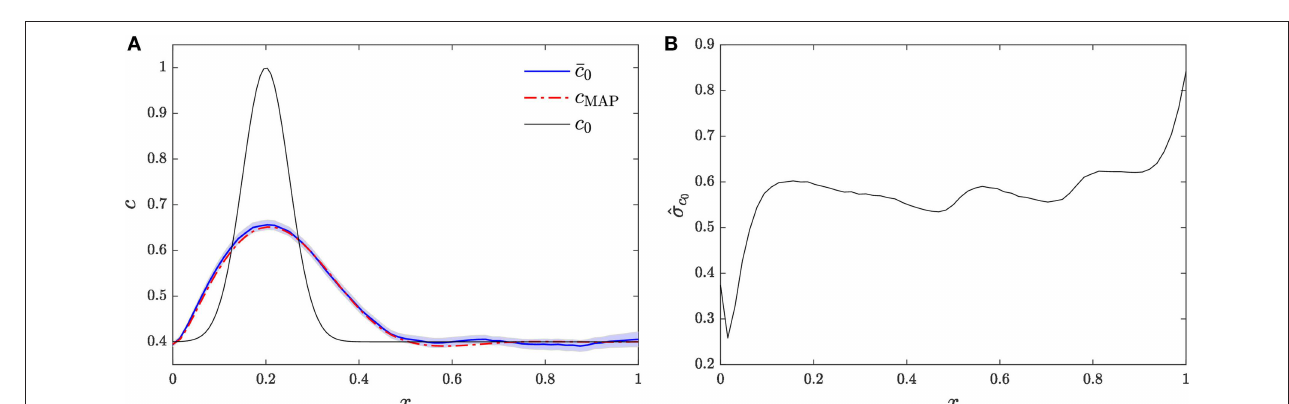
c 0 compared against MAP estimate c MAP and the actual release profile c 0 . (B) Posterior ¯